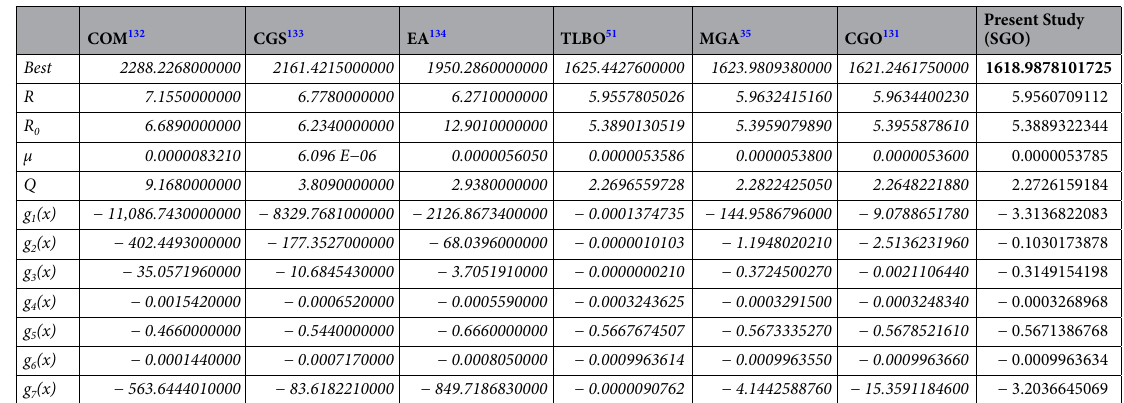
Table 12. Comparison of the best solutions for the hydro-static thrust bearing design problem. Bearing step radius (R), recess radius (R0), oil viscosity (µ), flow rate (Q). Significant values are in bold and